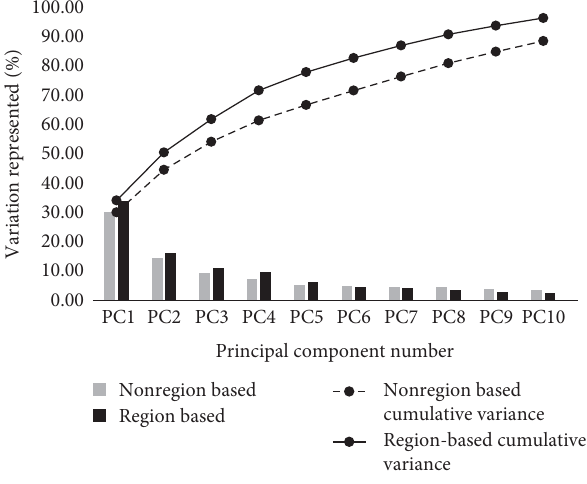
F IGURE 3: Comparison of cumulative variation percentages of nonregion-based SSM and region-based